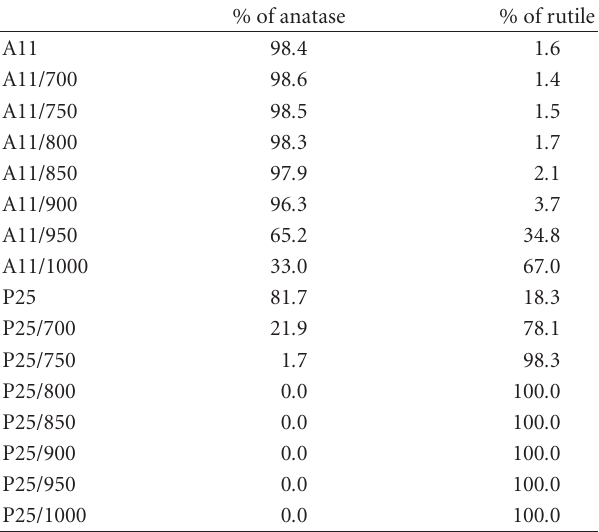
Table 2: The phase composition of A11 and P25